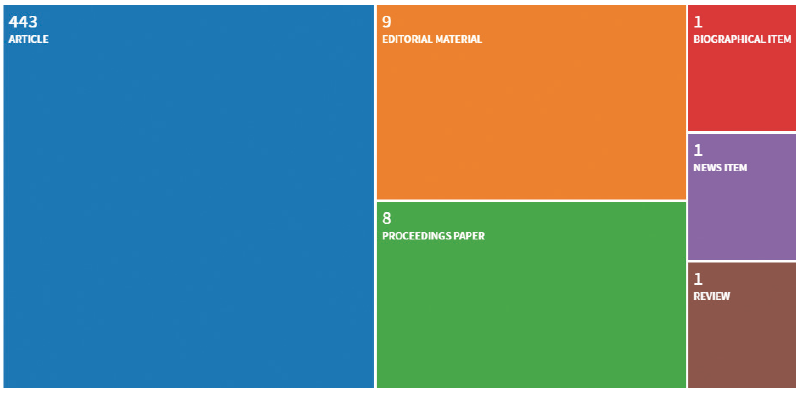
Figure 1. Types of the Baltic Journal of Road and Bridge Engineering